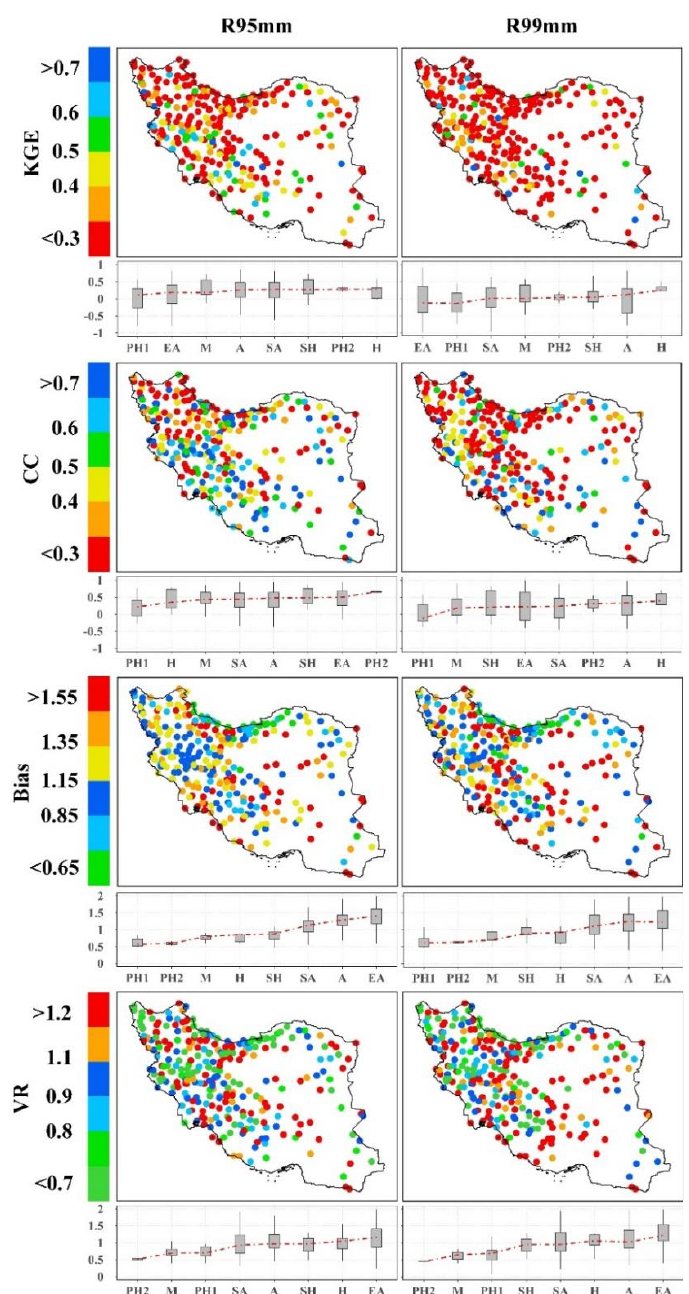
Figure 4. Reliability of GPM-IMERGV6.0 Final Run (GPM-IMERGF) in capturing percentile precipitation indices based on bias, correlation coefficient (CC), variability ratio, and Kling-Gupta efficiency (KGE) error metrics.